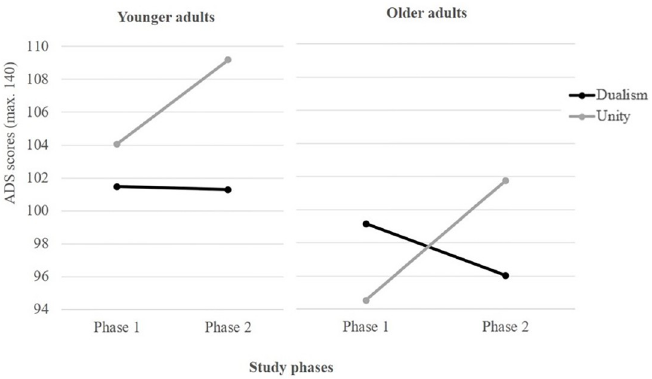
Fig 3. Effect on ADS of the interaction between framing, audience age, and the study phases controlling for experience with AD and importance of AD.